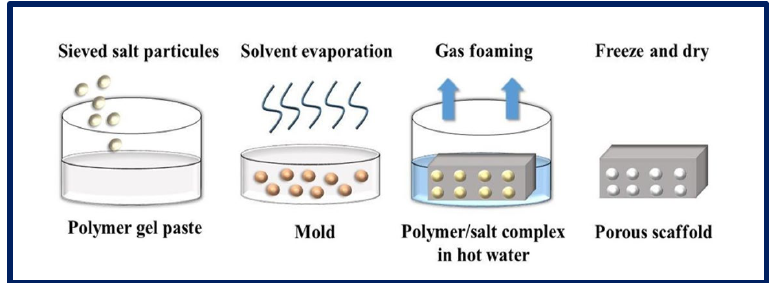
Figure 11. Gas formation process by chemical method for the production of porous scaffolds. Bibliography consulted [88].